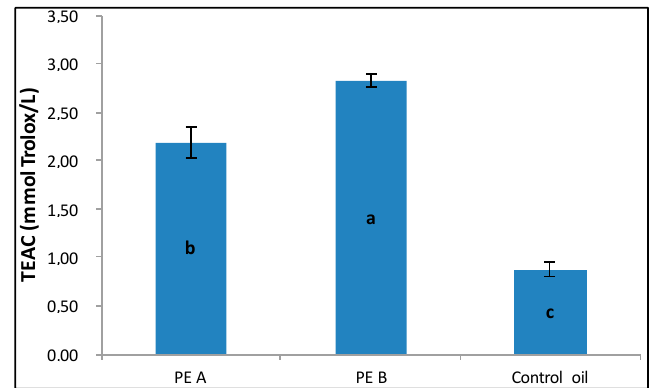
Figure 1. Trolox equivalent antioxidant capacity (TEAC) value determined for COO and both phenol-enriched olive oils. Parameters not sharing the same letter have a significantly different mean concentration ( α = 0.05).